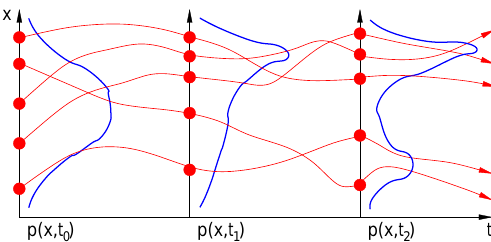
Figure 1. Schematic of an ensemble simulation (red trajectories), as an approximation to the simulation of an evolving probability distribution (in